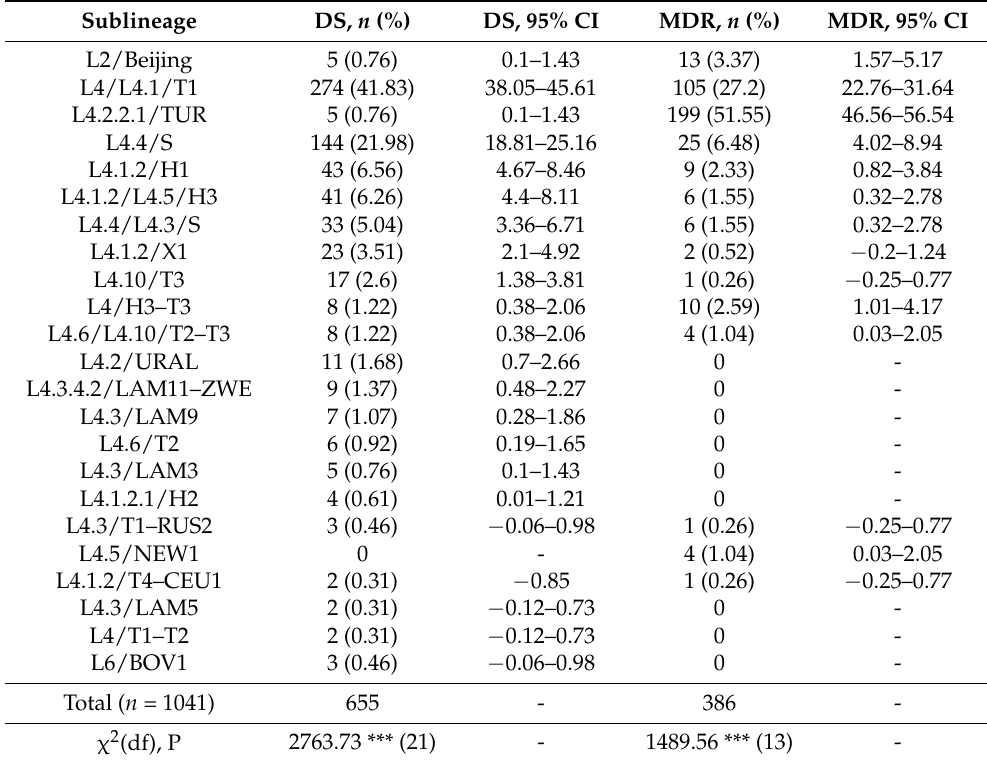
Table 1. Identified spoligotype lineage and sublineages as defined in the SITVIT2 database and inferred lineage and sublineage WGS-naming. When identical spoligotype signatures cover different sublineages, they are reported when known. Number of identified strains and prevalence in percent- age among drug-sensitive (DS) and multidrug-resistant (MDR) MTBC sublineages in Bulgaria for the period